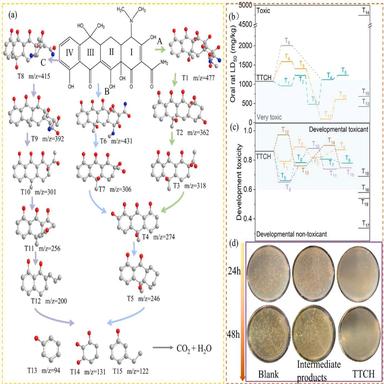
(a) The plausible degradation pathway for TTCH by EMFe0.2S/PMS oxidation system; Toxicity of TTCH and the degradation intermediates: (b) oral rat LD50; (c) development toxicity. (d) the images of Escherichia coli growth for blank, undegraded TTCH and degraded TTCH intermediate. Reaction conditions: = 20 ppm, = 0.15 g L− 1 , = 0.15 g L− 1 , and T = 25 ◦C.